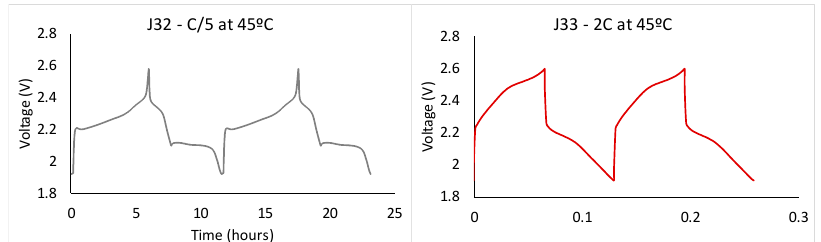
Figure 2 . Charge/discharge voltage profile of a cell cycling at C/5 (left) and at 2C (right) . Figure 2. Charge / discharge voltage profile of a cell cycling at C / 5 (left) and at 2C (right).